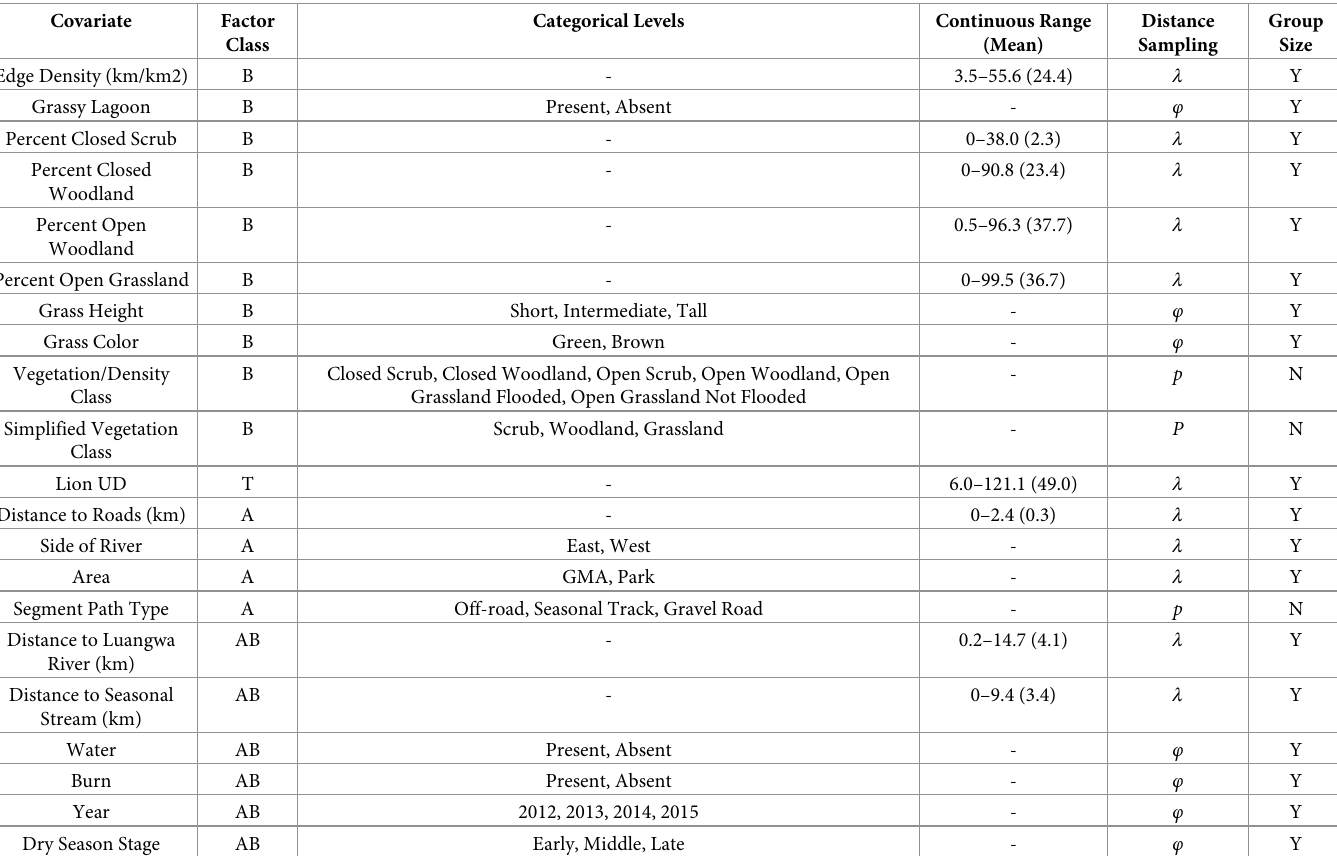
Table 1. A summary of all covariates that were thought to impact herbivore density, classified as Bottom-up (B), Top-down (T), Anthropogenic (A), or Abiotic (AB). Covariates were considered in distance sampling models to impact group super-population ( λ ), availability for sampling ( φ ), or detection ( p ). Covariates were (Y) or were not (N) considered in models predicting group